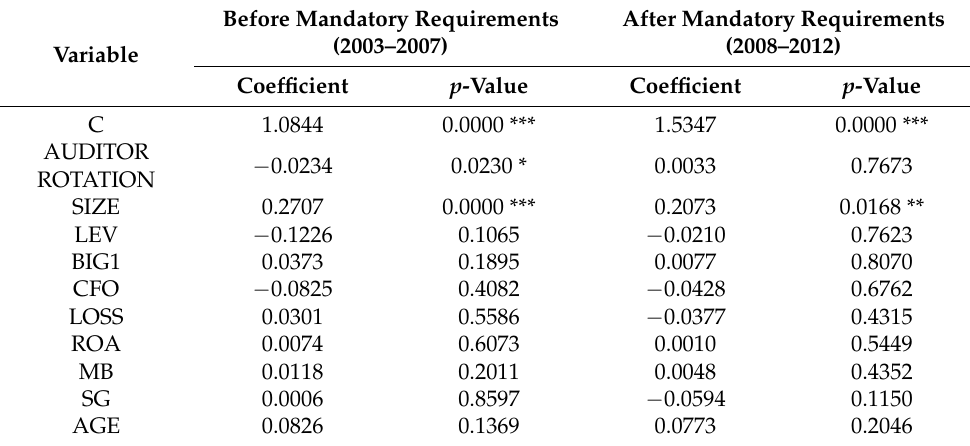
Table 12. The results of the third